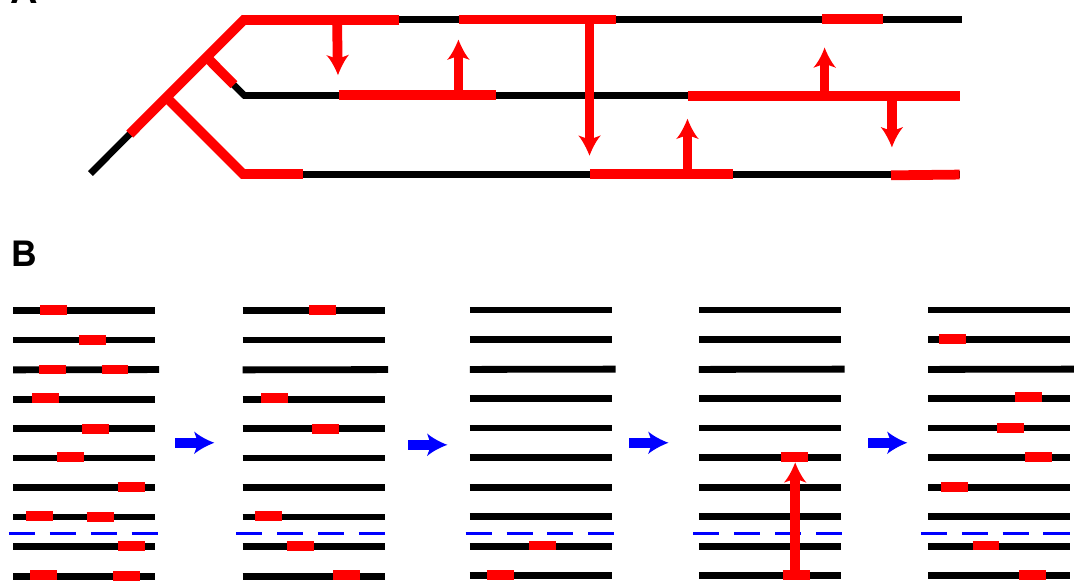
Figure 4. Dynamics of transposable element (TE) resurrection. ( A ) Iterated rounds of horizontal transfer (either through hybridization or other mechanisms) between sympatric close relatives allows extinction events to be followed by new rounds of proliferation. ( B ) Population subdivisions (indicated with the blue dashed line) allow a TE lineage to decrease in abundance, go extinct from one population, but become resurrected through contact with an isolated refuge population.